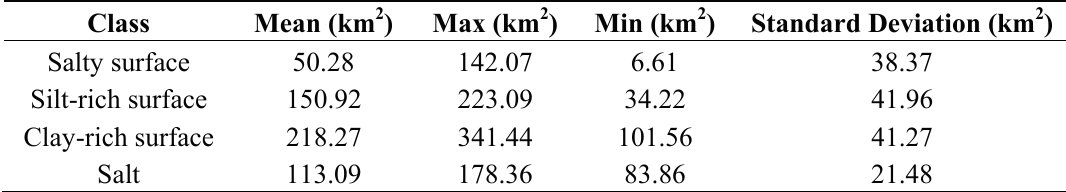
Table 5. Statistics of areas of each